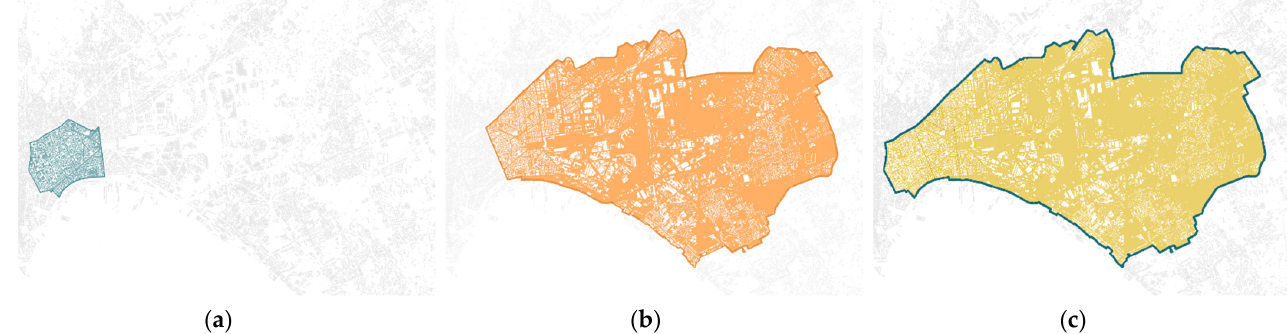
Figure 2. The perimeter of the study area: ( a ) Great UNESCO Project; ( b ) METROPOLIS Project; ( c ) Study area.